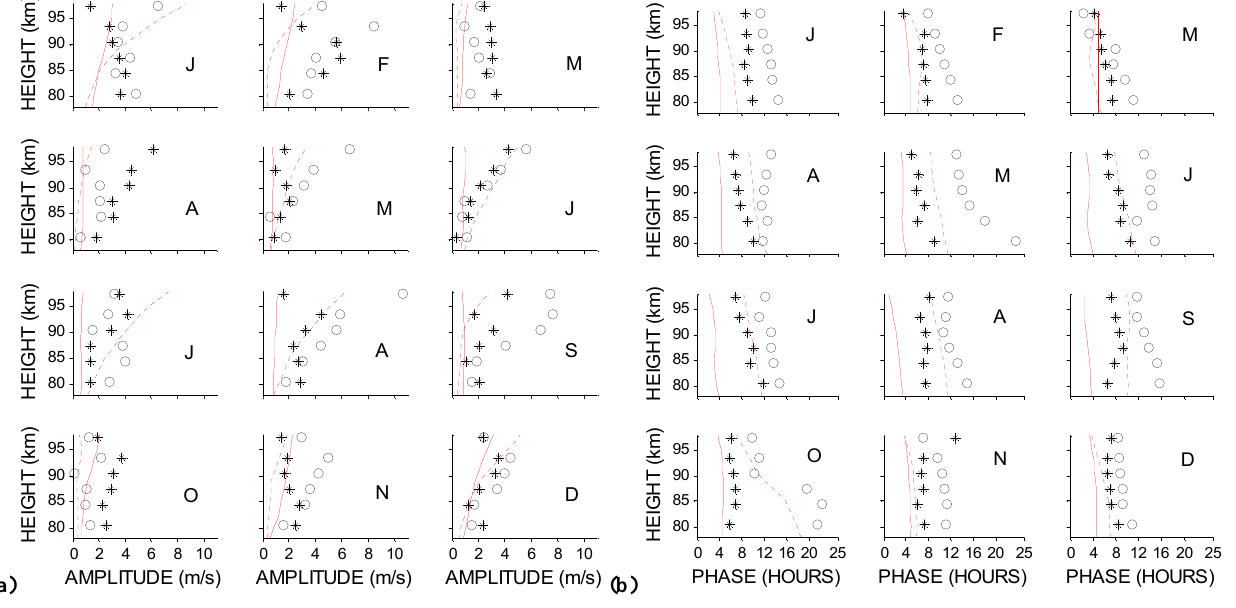
Fig. 3. Monthly amplitude and phase plots of the Lunar M 2 tide over Ascension Island. Black symbols indicate tidal amplitudes calculated from the Ascension Island meteor radar over the period 2001–2005 and the red lines indicate results from the Vial and Forbes (1994) model. Solid lines show the zonal (stars) component and dashed show the meridional